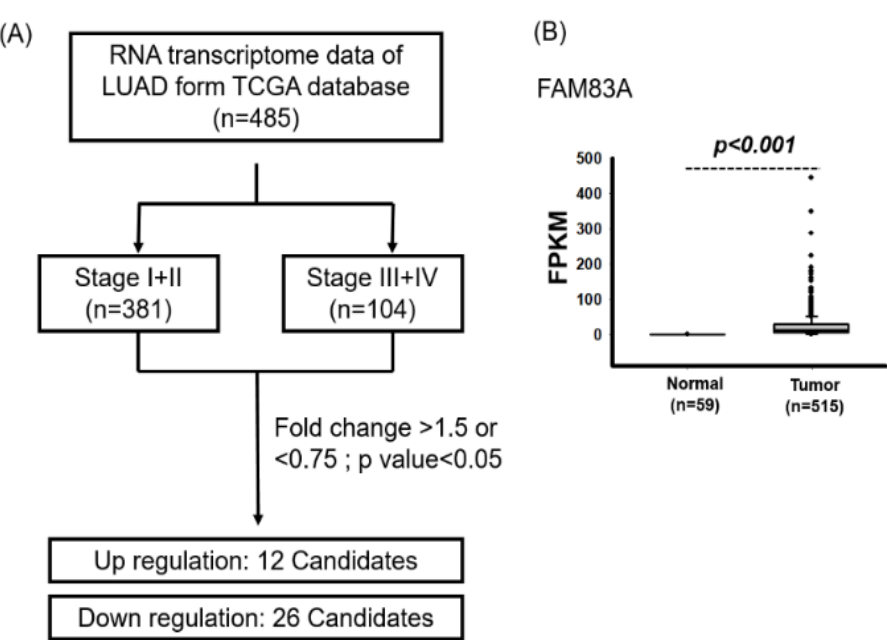
Figure 1. Identification of candidate genes associated with stage in lung adenocarcinoma (LUAD) through TCGA database analysis. ( A ) Flowchart of the identification process. ( B ) Increased FAM83A expression in LUAD tissues compared with that in adjacent normal tissues.